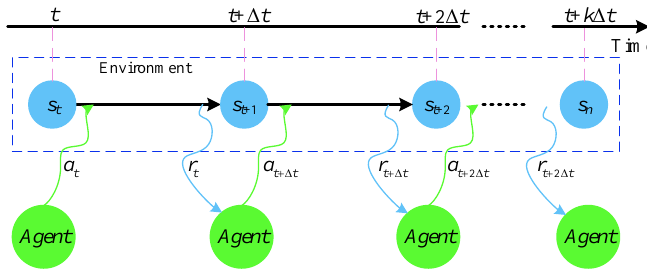
Figure 9. The operating process of the agent in a discrete environment in time